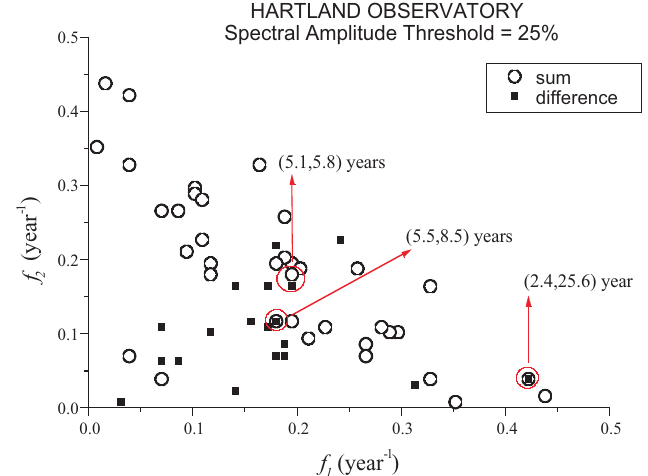
Fig. 7. The method of SPAQCE applied to the Y component of geomagnetic field SV from the combination of U.K. observatories reduced at Hartland location: three quadratic phase couplings are quite evident. QPC emerges from the superimposition of black squares and of white circles representing evidences of quadratic couplings in terms of differences and sums of couples of frequencies, respectively. The diagram is based on the 25% largest spectral